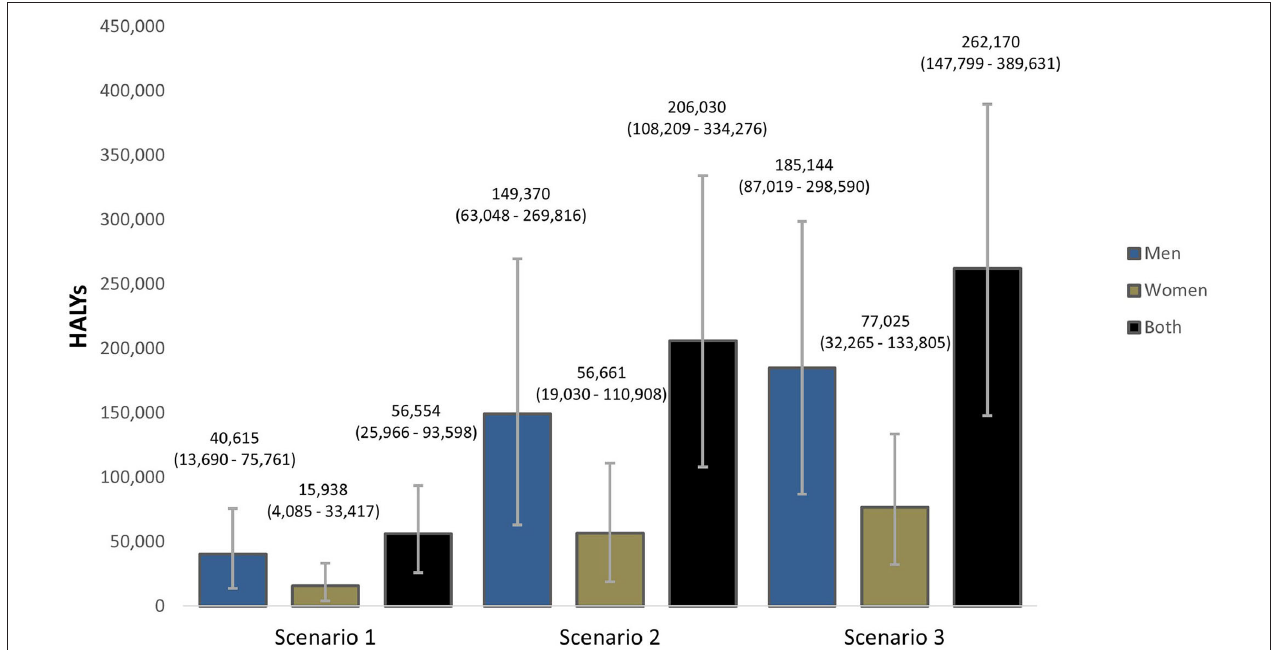
FIGURE 4 | Projected Health-adjusted life years (HALYs) that could be gained if the national (Scenarios 1 and 2) and WHO (Scenario 3) salt targets were achieved in Vietnam. The bars are the best estimates while the whiskers are the 95% uncertainty intervals, i.e., 2.5 and 97.5 percentiles.